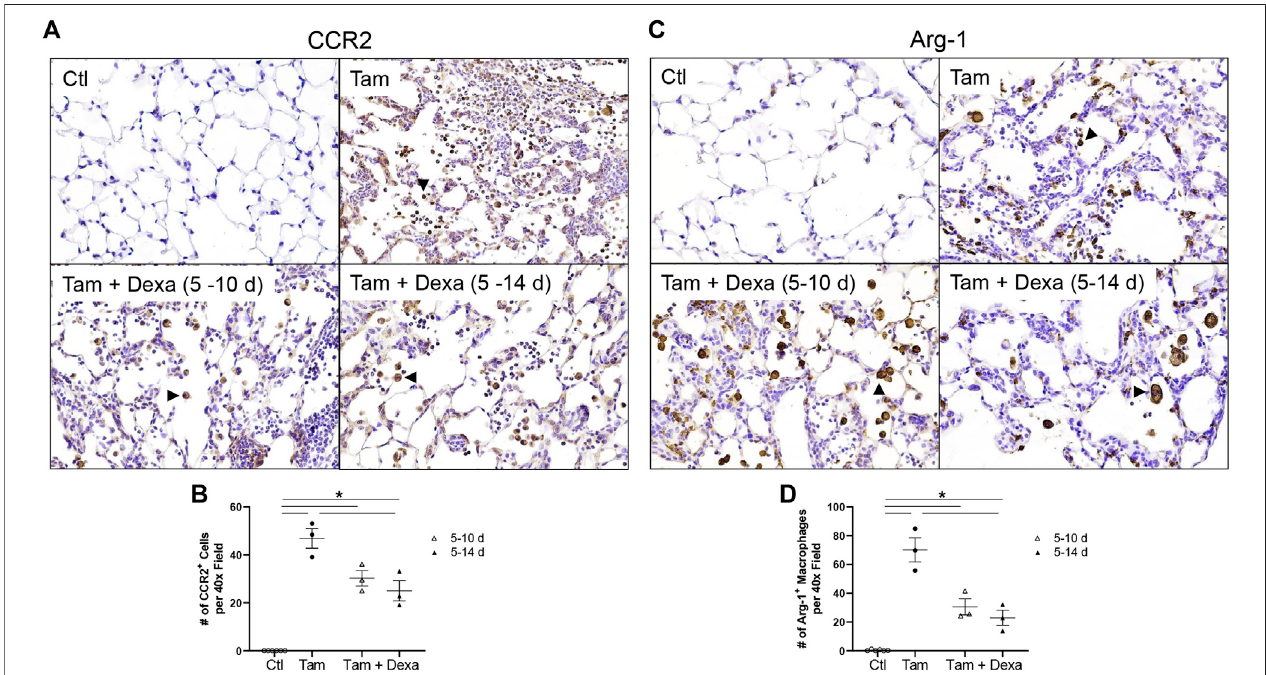
FIGURE 9 | Effects of dexamethasone administration on anti-in fl ammatory activation and monocyte recruitment during SP-C I73T induced injury. Lung sections immunostainedwithantibodyto (A) CCR2and (C) Arg-1fromcontrol(Ctl,oiltreatedSP-C I73T mice),tamoxifentreated,ortamoxifen+dexamethasonetreatedSP-C I73T mice 14 days after injury. Two dexamethasone groups are described (1 mg/kg), receiving daily i.p. injections between day 5 – 10 or 5 – 14 following tamoxifen induction. Binding was visualized using a Vectastain kit. Arrowheads indicate cells expressing the receptor. Original magni fi cation, ×400. Representative sections from 3 mice/group are shown. Quanti fi cation of each respective antibody is shown in (B,D) as the average number of brown/positive in fl ammatory cells in ×400 images of regions of injury. Data are presented as mean ± SD ( n = 3 mice/group), analyzed using two-way ANOVA. A p < 0.05 (*) was considered signi fi cant.